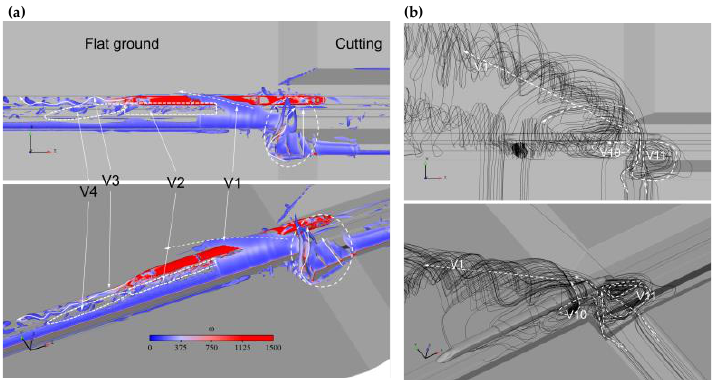
Figure 12. Flow structures around the train at t* = 65: ( a ) vortex distribution ( Q = 5000) and ( b ) space streamlines.